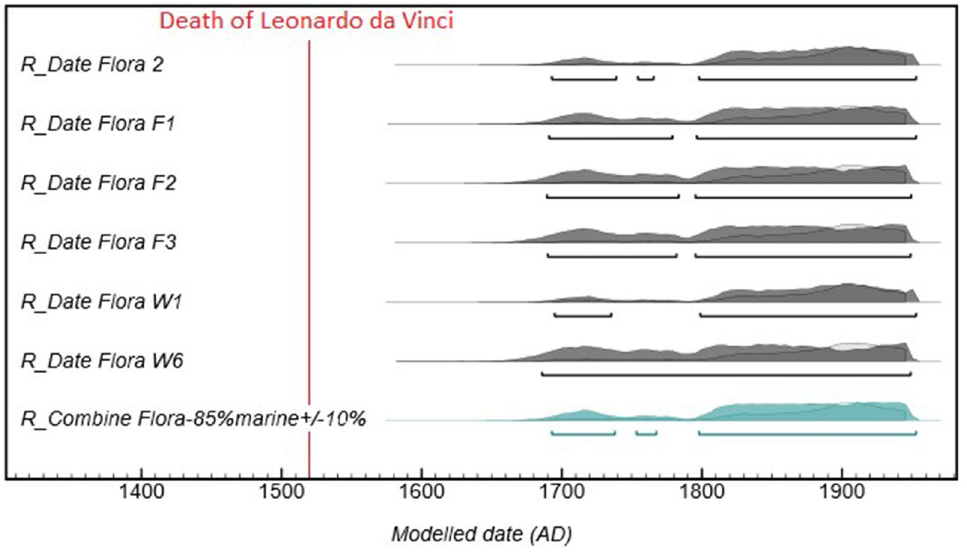
Figure 6. Calibrated 14 C dates for the wax samples of the Flora bust using a combination of 15% atmospheric/85% marine (± 10%) calibration curves (in dark grey). The statistical combination of the three dates in blue gives the interval of 1707–1950